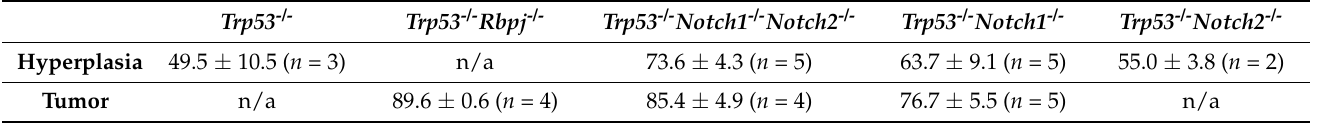
Table 1. PCNA + cells (% of GFP + cells) in hyperplasias and tumors. Data represent mean ± standard deviation.